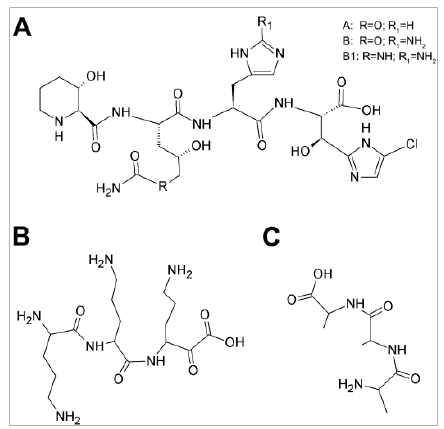
Figure 1. Structures of GE81112, tri-ornithine and tri- L -alanine: ( A ) GE81112 (variant B, MW = 658 Da), the chlorine-containing tetrapeptide antibiotic consists of four non-proteinogenic amino acids (3-hydroxypipecolic acid, 2-amino-5-[(aminocarbonyl) oxy]-4-hydroxypentanoic acid, histidine, and 5-chloro-2-imidazolylserine) [2,4]; ( B ) tri- L -ornithine; and ( C ) tri- L -alanine.